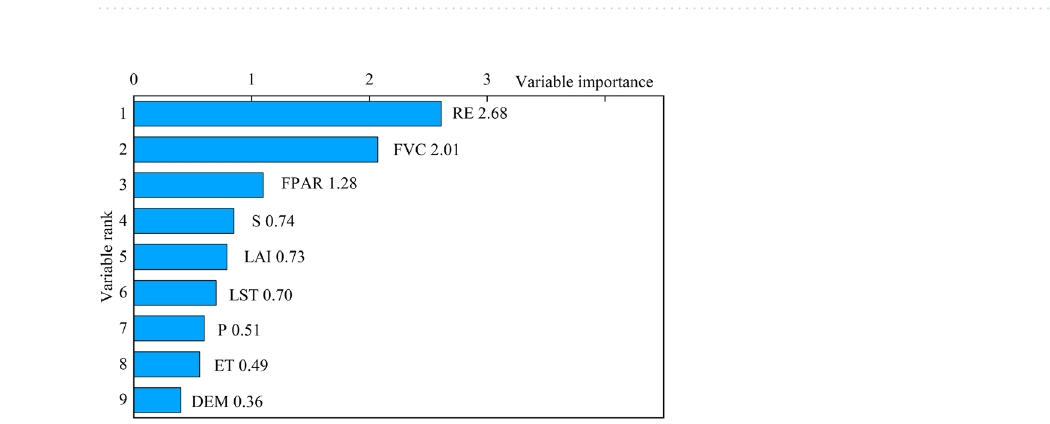
Table 2. Accuracy of the RF, including the kappa, OA, UA, and PA.